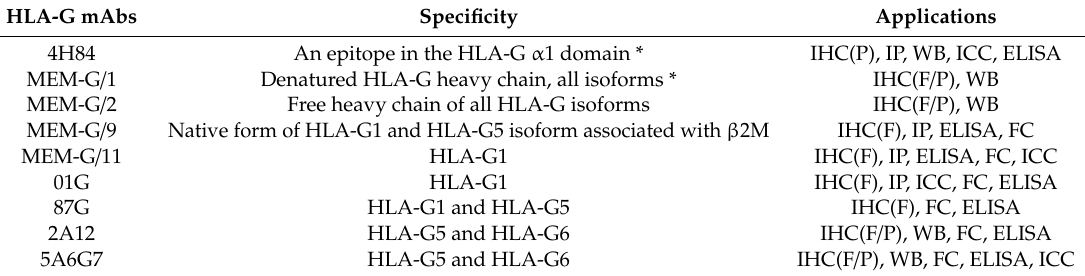
Table 1. Overview of HLA-G-recognizing antibodies and their specificity and applications. HLA-G Specificity Applications mAbs